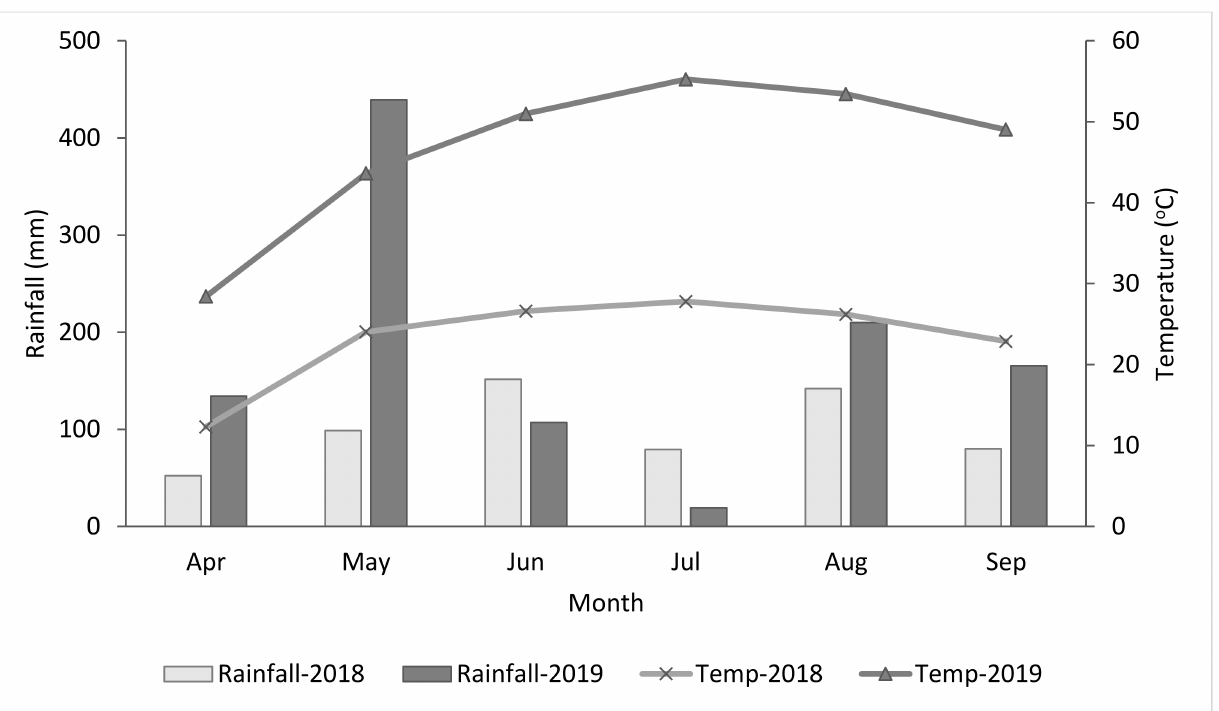
Figure 1. Total rainfall and average air temperature (April to September) in 2018 and 2019 at Stillwater, OK,